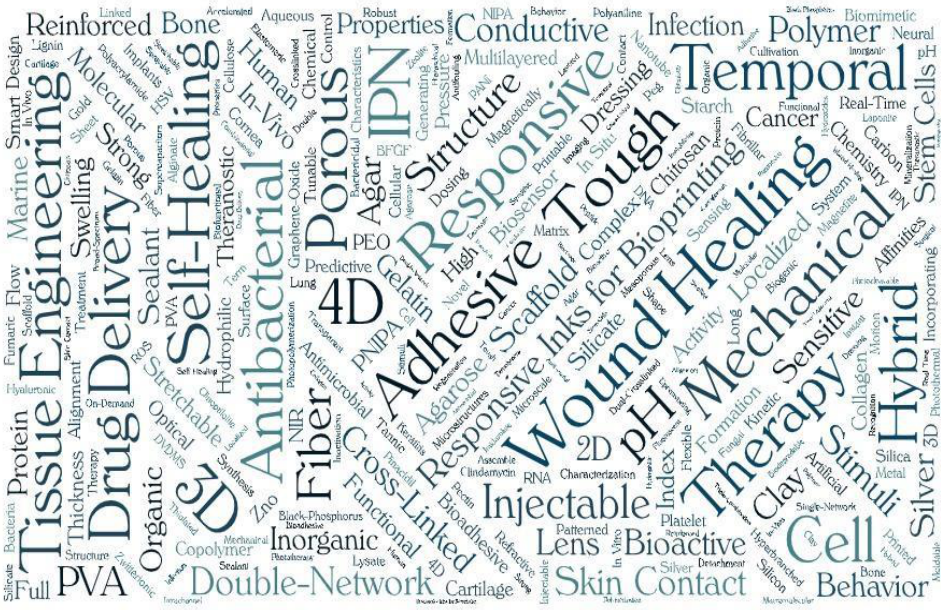
Figure 2. A word cloud generated using the titles of the articles referenced in the review to highlight the broad applicability of multifunctional hydrogel nanocomposites in biomedical sciences and engineering. Word size approximately scales with the frequency of occurrence to highlight the key application